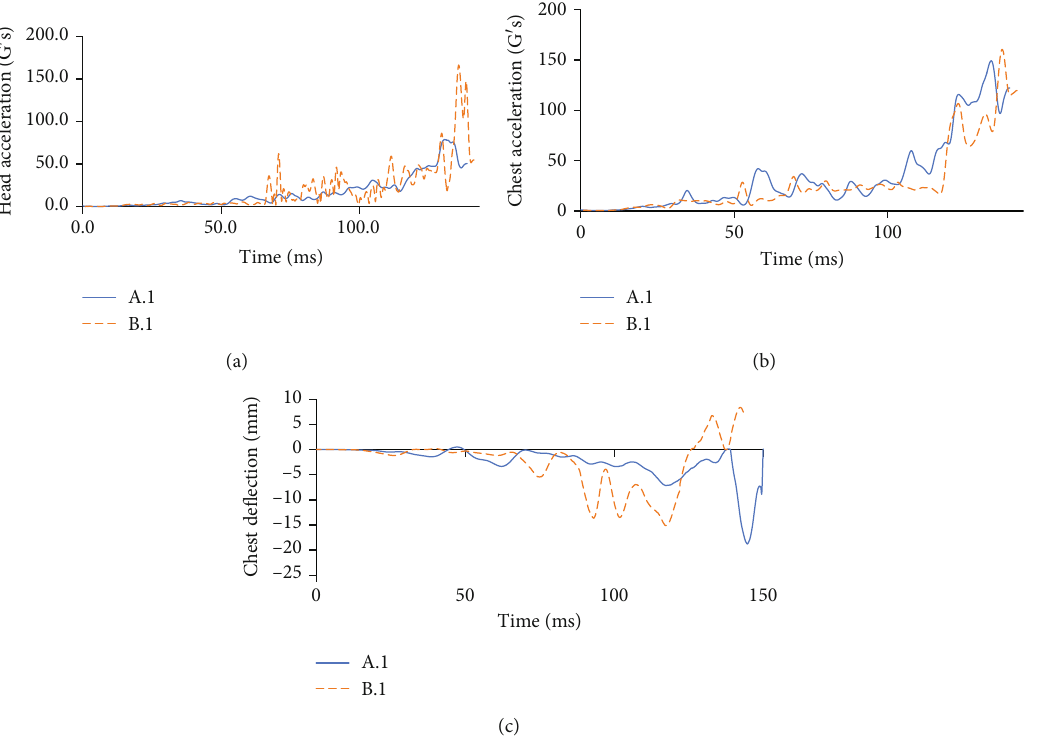
Figure 7: Impact on a cyclist on the overtaking stage at 60 km/h without a passive safety system (a) and with a passive safety system (b).